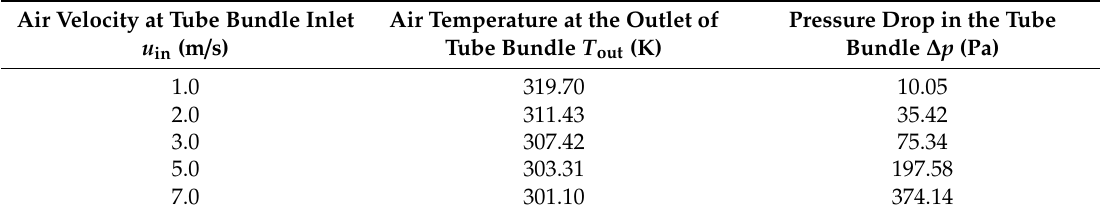
Table 6. Output data for the perforation hole Ø4 mm.